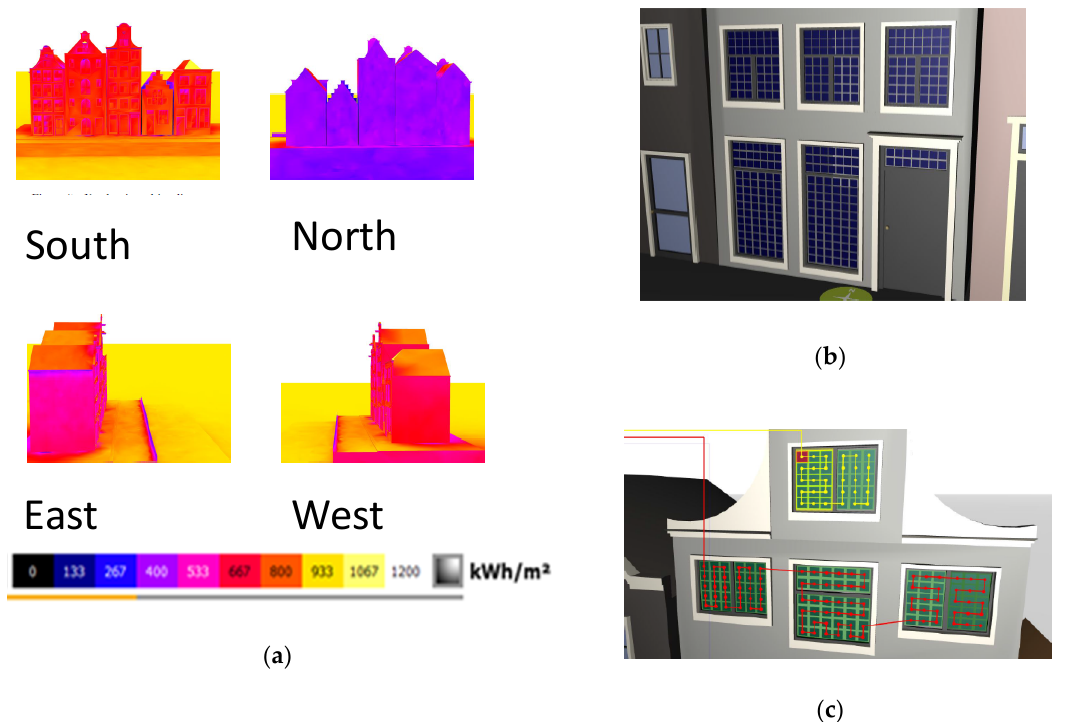
Figure 3. Average irradiance over the group of buildings ( a ), transparent BIPV windows ( b ) wiring of the BIPV cells and modules ( c ).